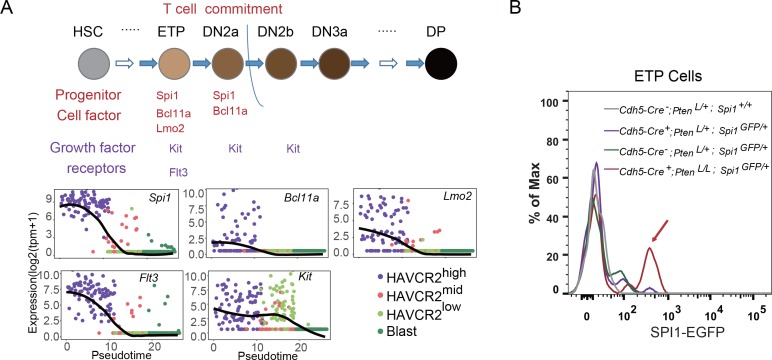
Spi1 is upregulated at the ETP/DN1 stage during T cell development.(A) Upper panel: Diagram of progenitor cell factors and growth factor receptors involved in early T cell development, modified from (Rothenberg et al., 2016); lower panels: pseudotemporal ordering of single cells based on Spi1, Bcl11a, Lmo2, Flt3 and Kit expression; (B) Spi1-GFP expression is upregulated in ETP/DN1progenitor cells from Cdh5-Cre+;PtenL/L;Spi1GFP/+Pten null (red line), compared to that in Cdh5-Cre-;Pten+/L;Spi1+/+ WT (gray line), Cdh5-Cre+;Pten+/L;Spi1GFP/+Pten heterozygous (purple line) and Cdh5-Cre-;Pten+/L;Spi1GFP/+ WT GFP+ (green line) mice.